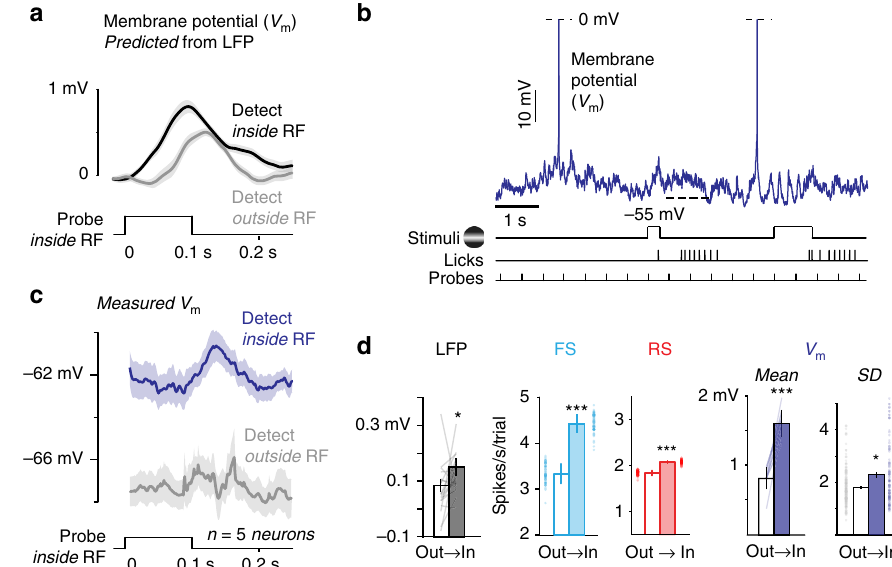
Fig. 7 Selective enhancement of network, cellular, and subthreshold activity. a Membrane potential (V m ) response predicted from LFP probe responses on detect inside (black) versus detect outside RF trials (gray). Mean ± s.e.m. Predictions generated from simultaneous LFP-Vm recordings outside of task (Supplementary Fig. 11). b Example whole-cell patch – clamp recording of V m during visual spatial detection. Spikes truncated at 0 mV. Time course of grating stimuli, correct detection (licks), and probe stimuli at bottom. c Membrane potential response is signi fi cantly more depolarized on trials with detection inside the RF (black, Δ 2.2 ± 0.3 mV from 0.1 to 0.2 s, detect inside minus outside after DC subtraction, p < 0.001, signed-rank test, n = 5 neurons). d Spatial contextual modulation of probe-evoked LFP responses (79 ± 0.3%) signi fi cantly larger than for FS (32 ± 0.01%) or RS responses (13